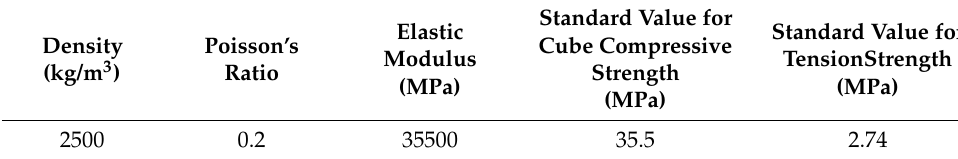
Table 17. Concrete material